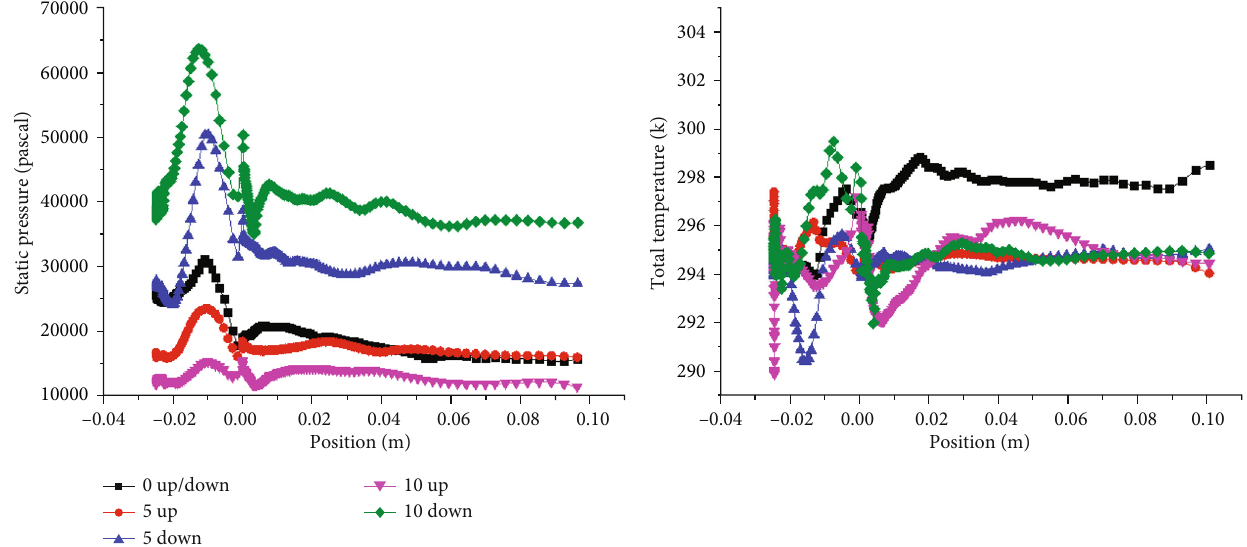
Figure 21: Pr=0.6 wall pressure and temperature distribution at di ff erent angles of